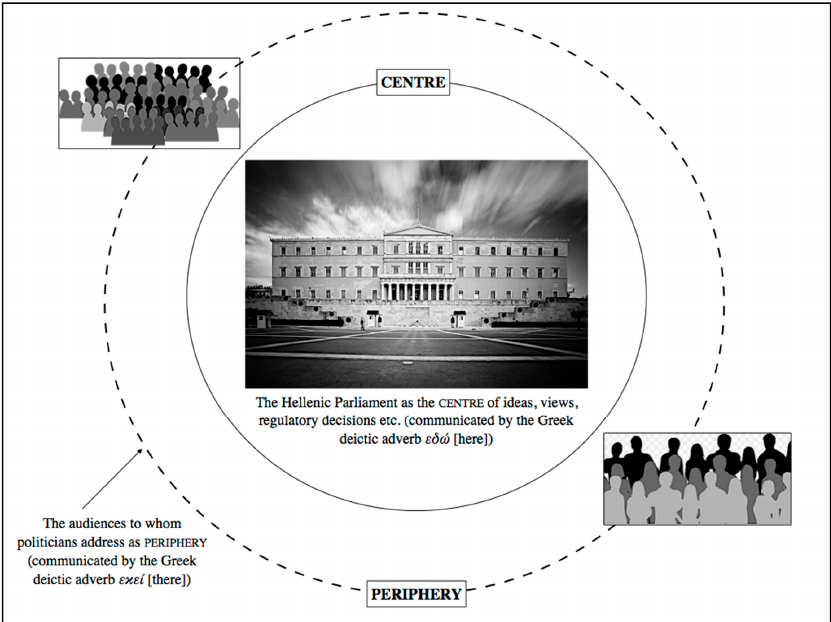
Figure 3. The centre - periphery image schema communicated by the use of the Greek deictic adverbs εδ ´ ω [here] and εκε ´ ι [there] in political